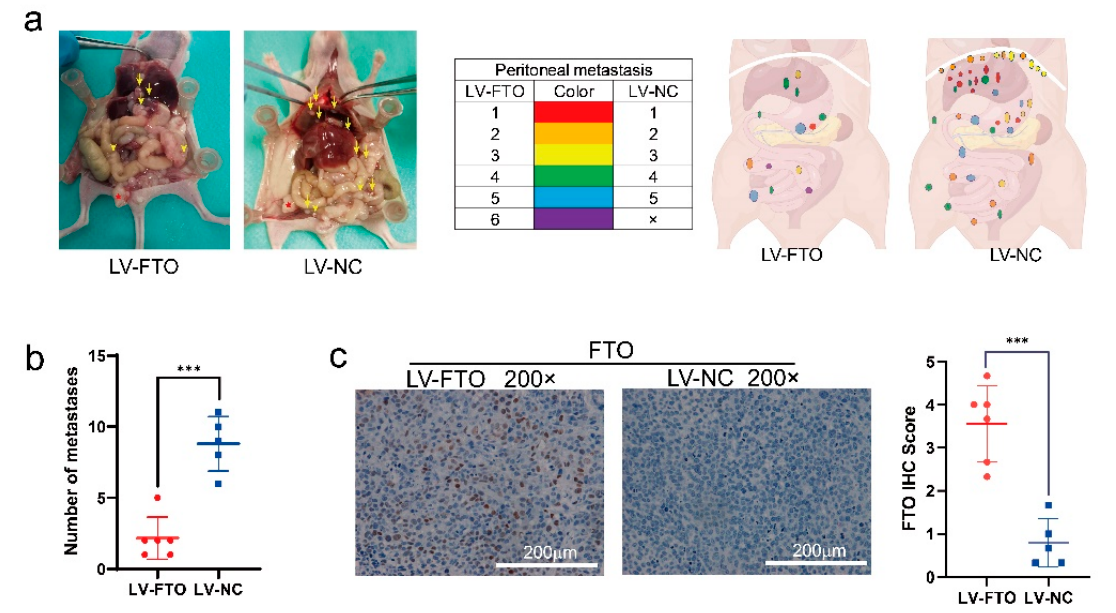
Figure 8. FTO inhibits EOC cell metastasis in vivo. ( a ) Tumour distribution at necropsy. Each colour represents the metastatic tumours from one mouse (n = 6). Red star indicates in situ lesion. Yellow arrow indicates metastatic focus. ( b ) The number at the endpoints of peritoneal xenograft metastatic tumours. ( c ) Representative images of IHC display the expression of FTO of peritoneal xenograft metastatic tumours. Scale bar, 200 μ m. Data are presented as mean ± SD; *** p < 0.001.